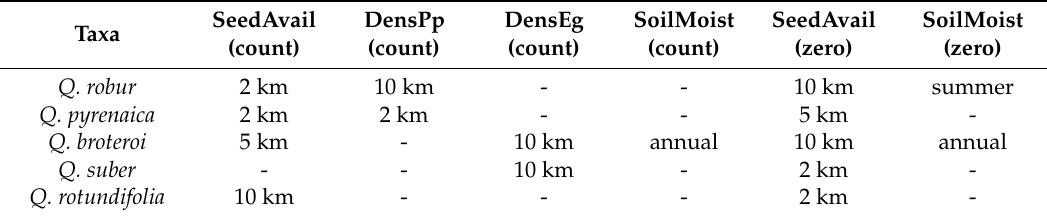
Table 4. Neighbourhood dimensions and soil moisture weight selected for final run; shown only when